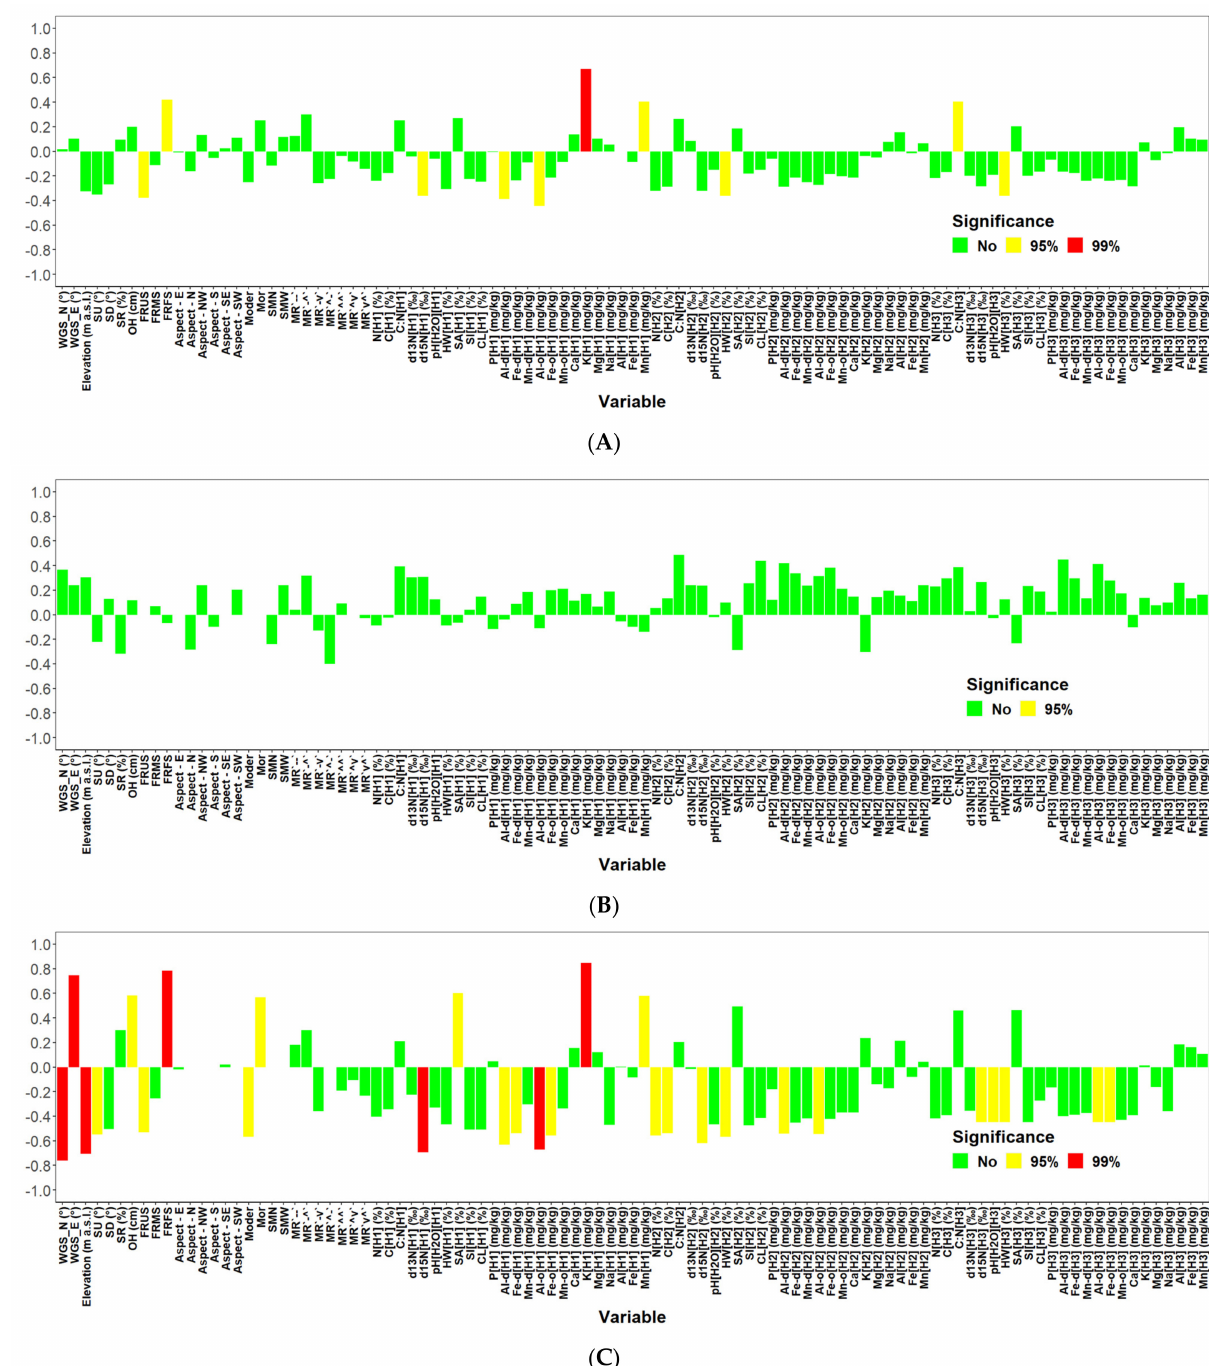
Figure A5. Correlation analysis of site characteristics with tree biomass (living + dead) for both locations (Keta, Lama) together ( A ), Keta ( B ) and Lama ( C